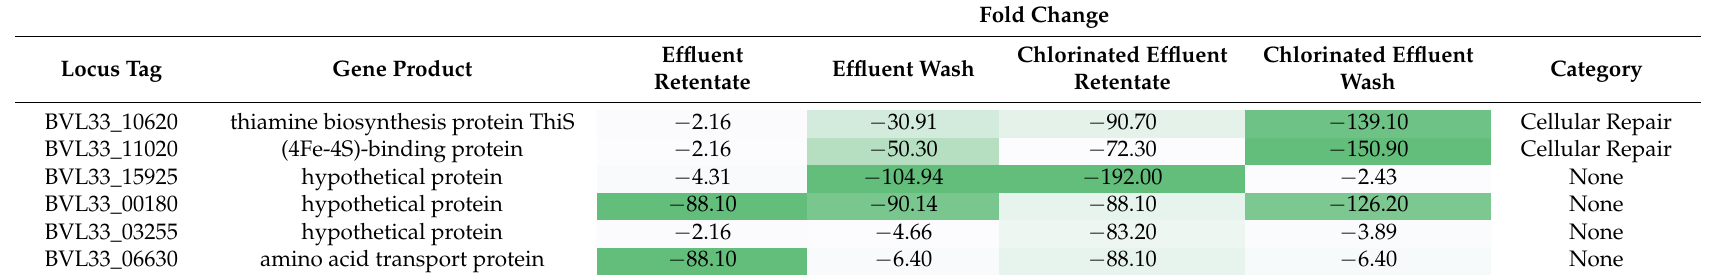
Table 2. Genes of Acinetobacter junii that were downregulated in both the effluent and chlorinated effluent. The gene expression values of the effluent-retentate and chlorinated effluent-retentate were compared to the gene expression values of the influent-retentate. The gene expression values of the effluent-wash and chlorinated effluent-wash were compared to the gene expression values of the influent-wash. Each of these downregulations were included if they were less than − 2-fold change and were statistically significant ( p < 0.05) on the Baggerly proportion-based test. The magnitude of downregulation is indicated by the intensity of green